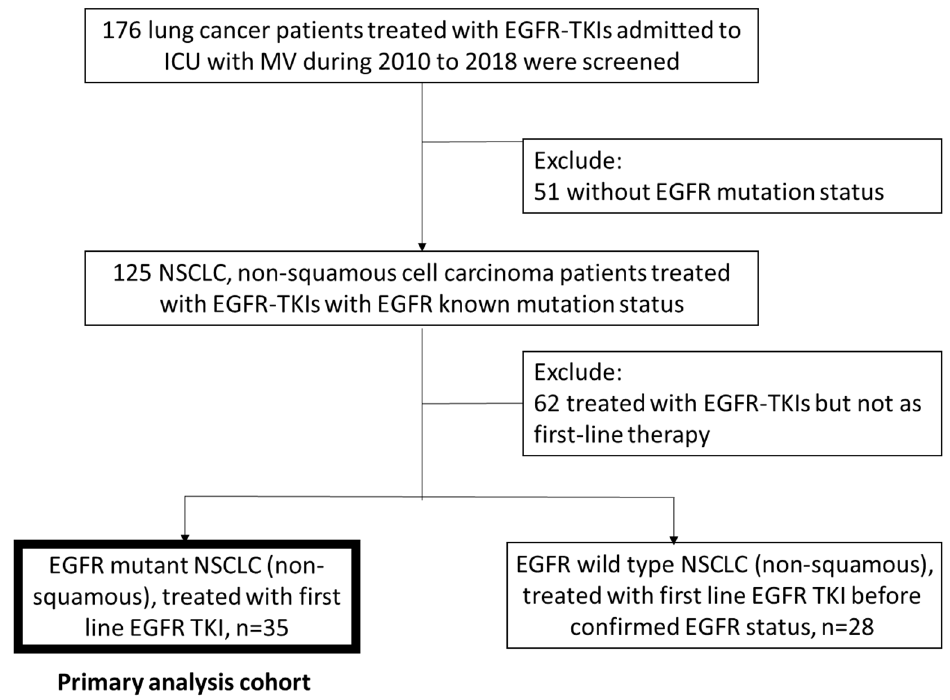
Figure 1. Consortium diagram of our study. Acronyms: EGFR = epidermal growth factor receptor, ICU= intensive care unit, MV = mechanical ventilation, NSCLC = non-small cell lung cancer, TKI = tyrosine kinase inhibitor.